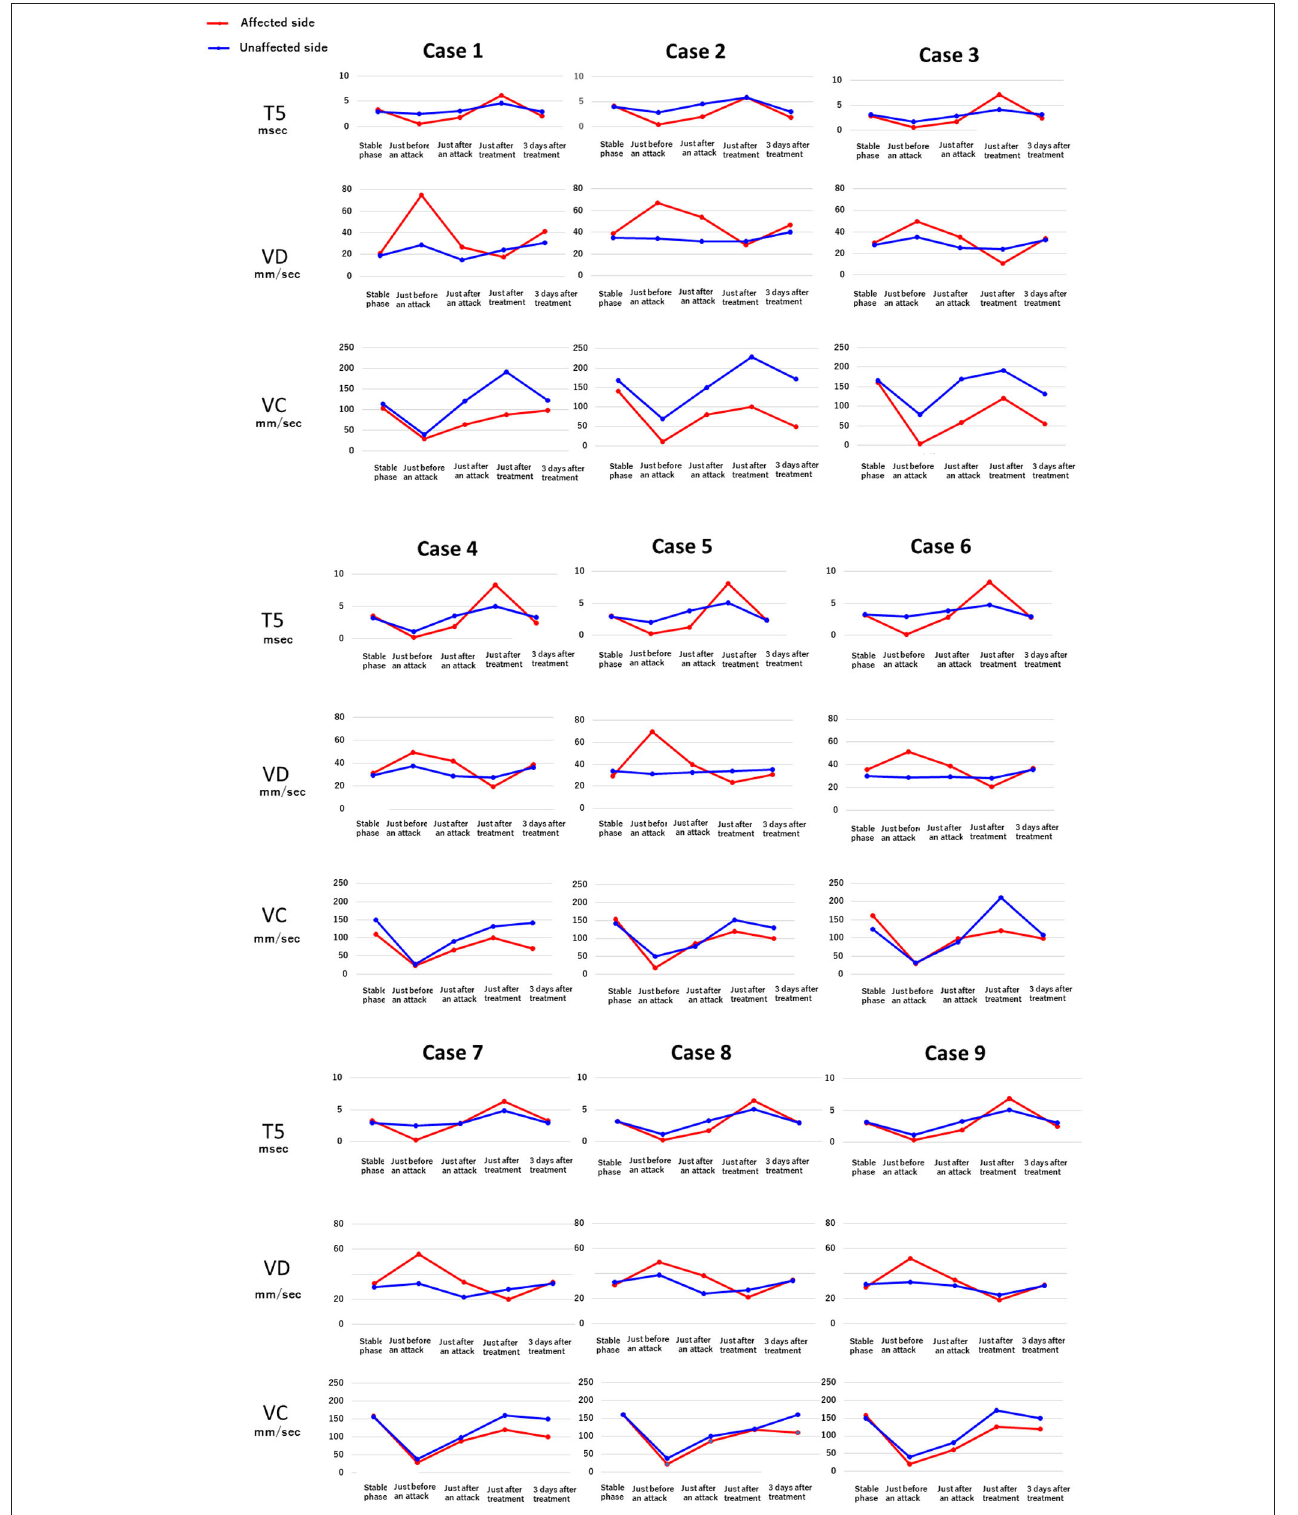
FIGURE 4 | Temporal changes in the electronic pupillometry data and symptoms in nine patients. Immediately before an attack, hyperactivation of the sympathetic nervous system and suppression of the parasympathetic nervous system were found, resulting in relative overactivation of the sympathetic nervous system. Maximum dilation velocity, VD (mm/sec): larger values indicate a more activated the sympathetic nervous system. T5 (msec): smaller values indicate a more activated sympathetic nervous system. Maximum constriction velocity, VC (mm/sec): larger values indicate a more activated parasympathetic nervous system.